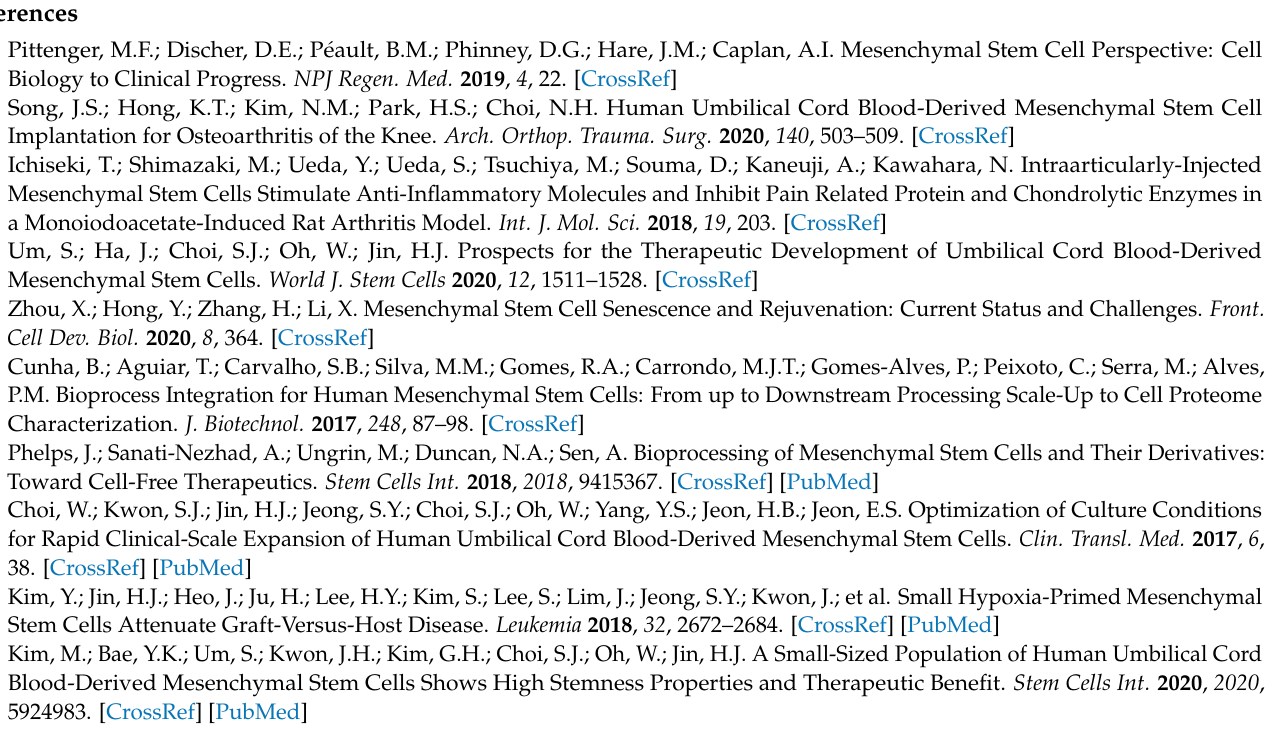
Experimental design in vivo, Table S8: Percent of weight on the ipsilateral